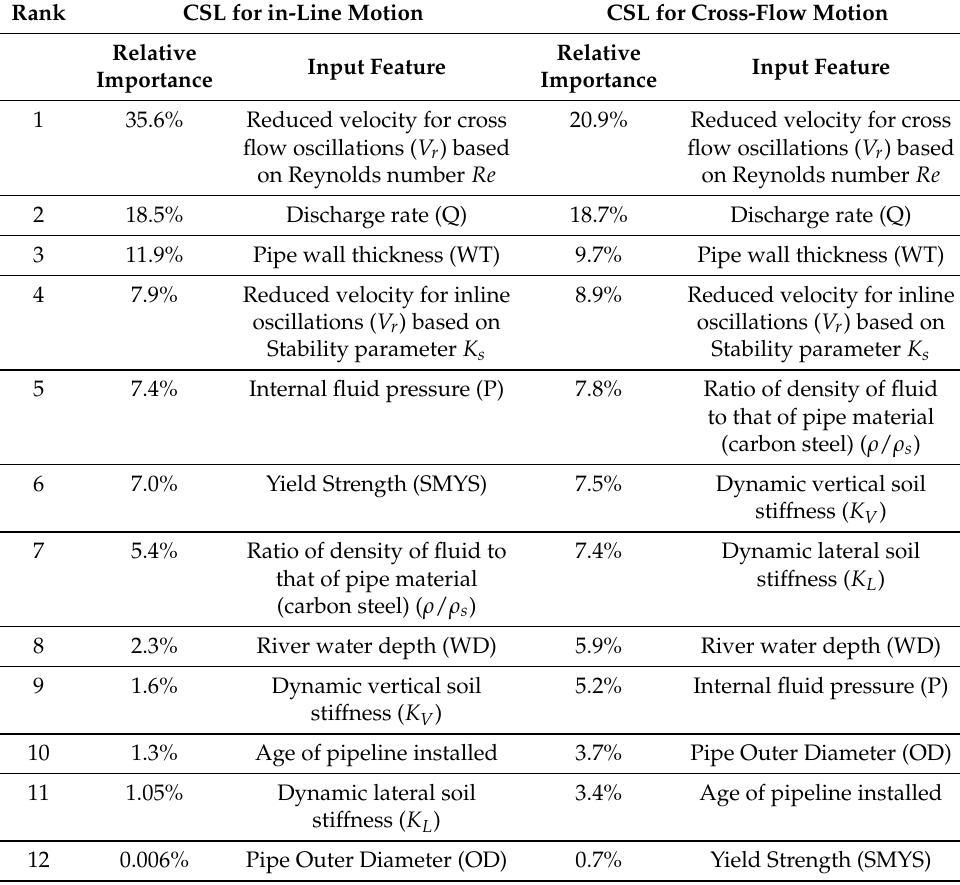
Table 9. Relative importance of input parameters in predicting critical span